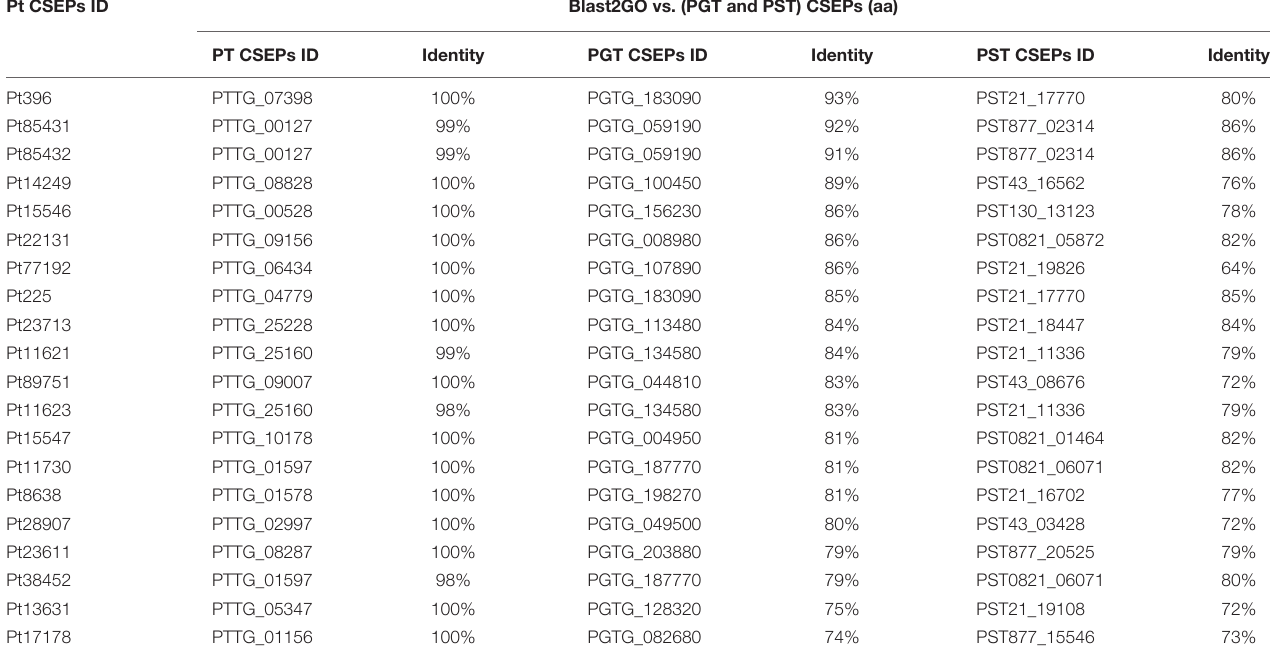
TABLE 2 | Identity of the 20 candidate effector proteins to other wheat rust fungi. Pt CSEPs ID Blast2GO vs. (PGT and PST) CSEPs